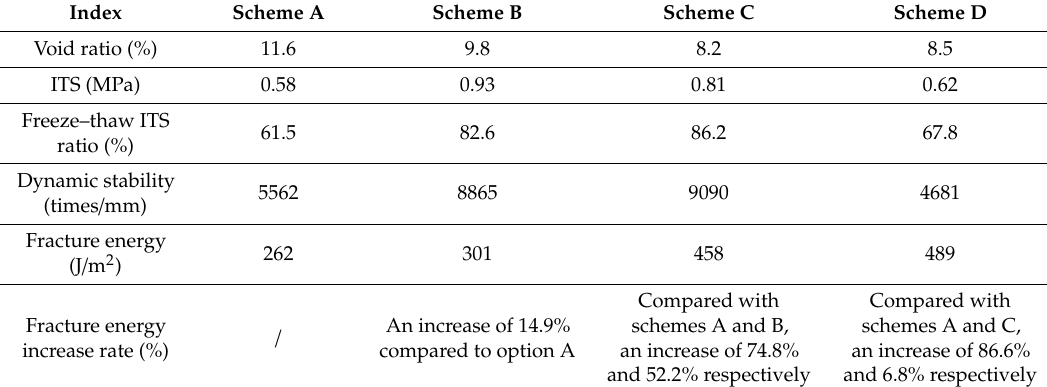
Figure 17. Comparison of mixture performance. Table 7. Comparison of mixture performance.